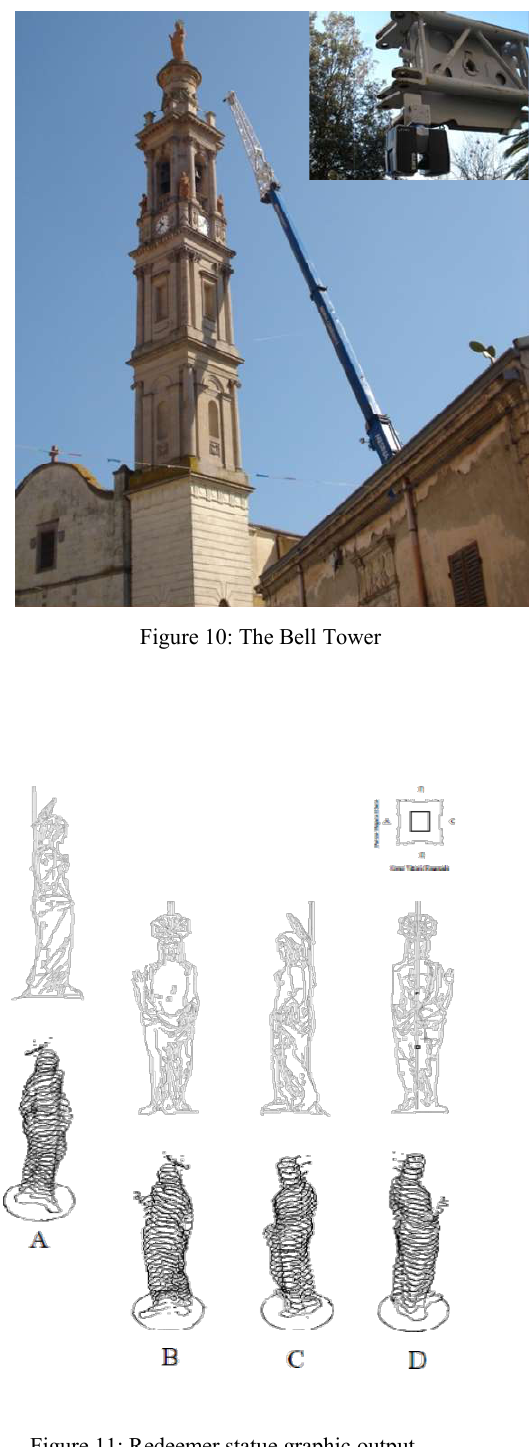
Figure 11: Redeemer statue graphic output